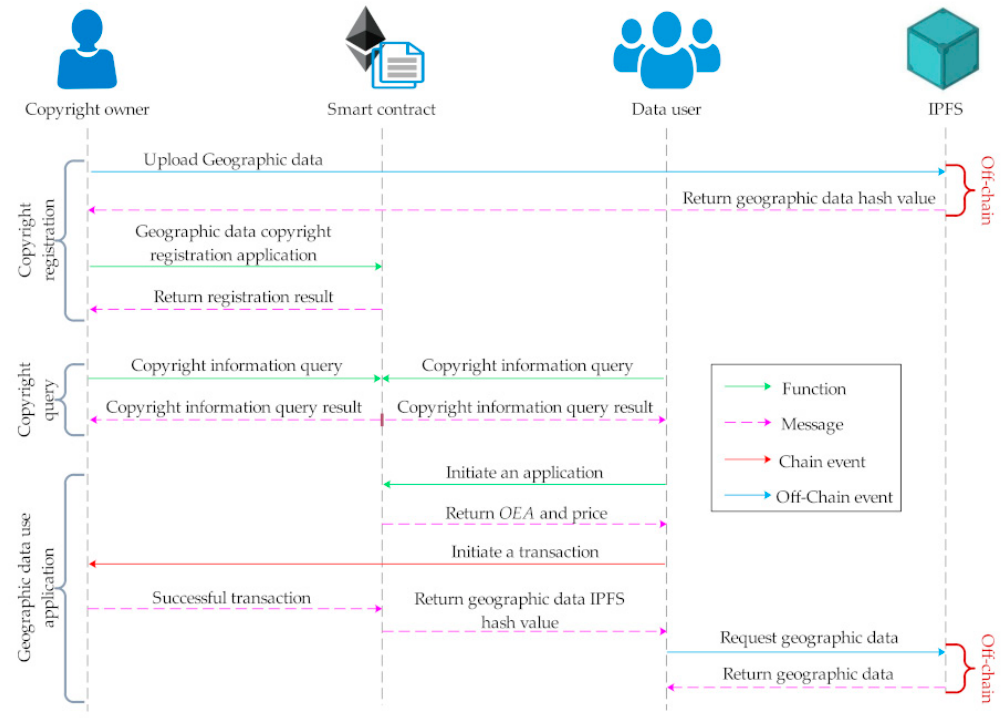
Figure 3. Spatial data copyright management function flow.